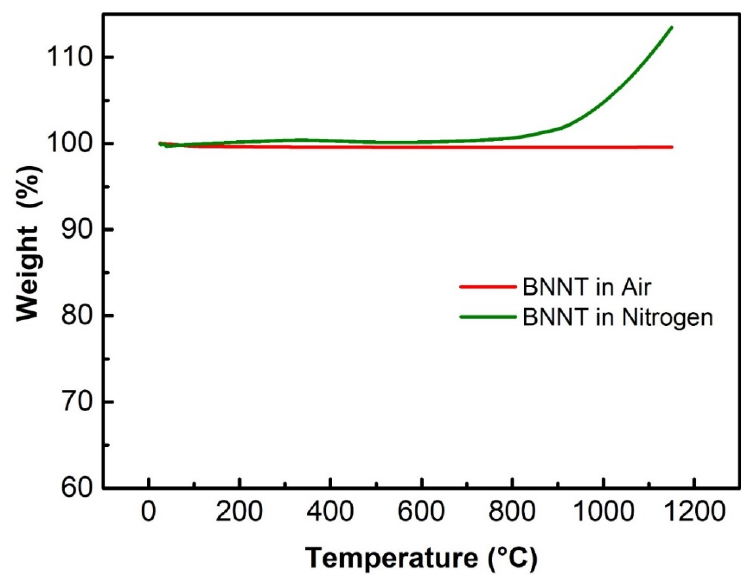
Figure 6. TG curves of the as-prepared BNNT in air and nitrogen.